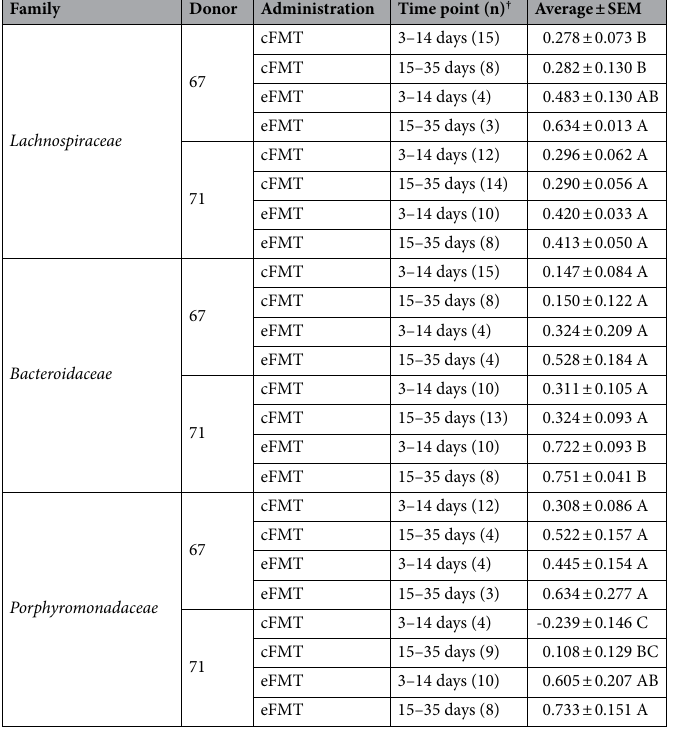
Table 3. Spearman correlations ( ρ ) between donor oligotype profiles and patient samples. † Families were not detected in all samples, resulting in variation in the sample sizes among groups. A,B,C Groups sharing the same letter did not differ significantly (Tukey’s post-hoc P >